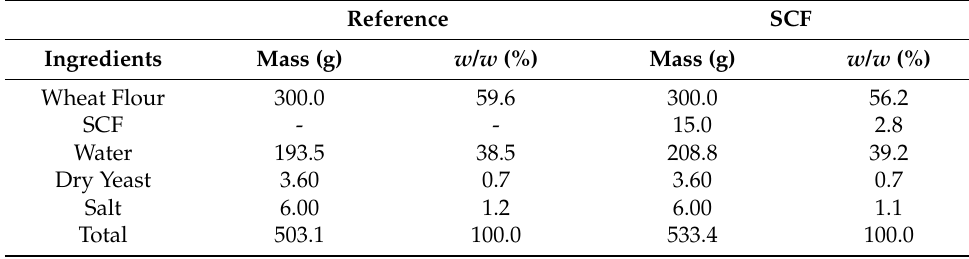
Table 1. Formulation of reference and SCF incorporated